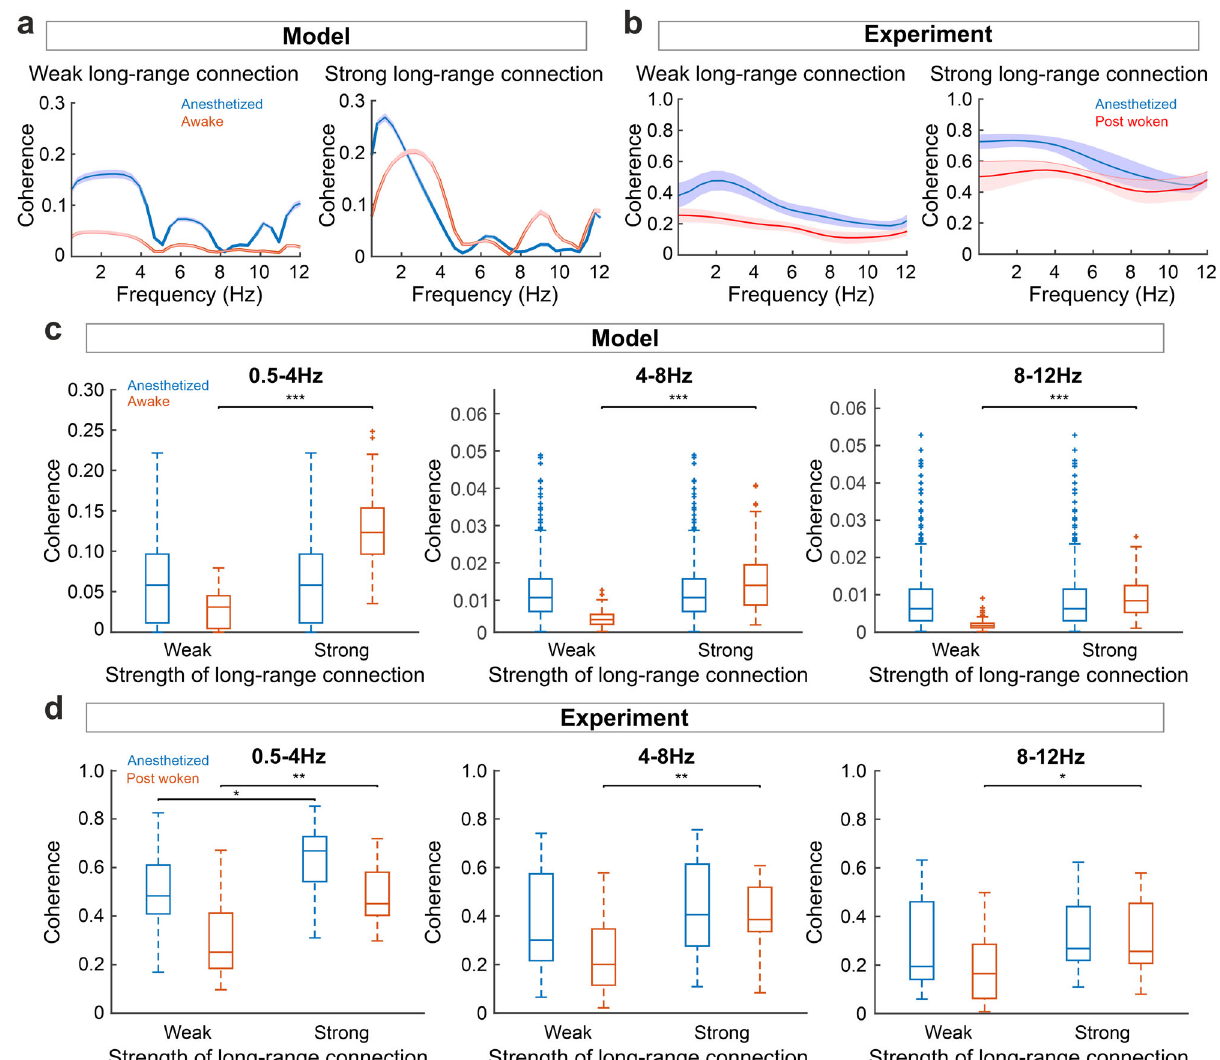
Fig. 7 | Long-range connections enhanced the coherence both in anesthetized andawakestate.a Activitycoherencebetweentwocorticalregionswithweakand strong long-range connections in the anesthetized and awake states in the model simulation (mean + SEM. SEM is indicated by the shading. Both N =100 trials). b Same as a , for experimental data (mean + SEM. SEM is indicated by the shading. Anesthetized state N =5 trials, post woken state = 5 trials). c Boxplots for activity coherence at different frequency bands between weakly (group of connection strength = 0, 5, 10) and strongly (group of connection strength = 20, 25, 30) con- nected cortical regions in the anesthetized and awake states in the model simula- tion. For boxplots, the center line indicatesthe median, the lower and upper limits of the box indicate the 25% and 75% percentiles, and the whiskers give the max- imum and minimum values. Outliers are indicated with “ + ” . Both N =300 trials.